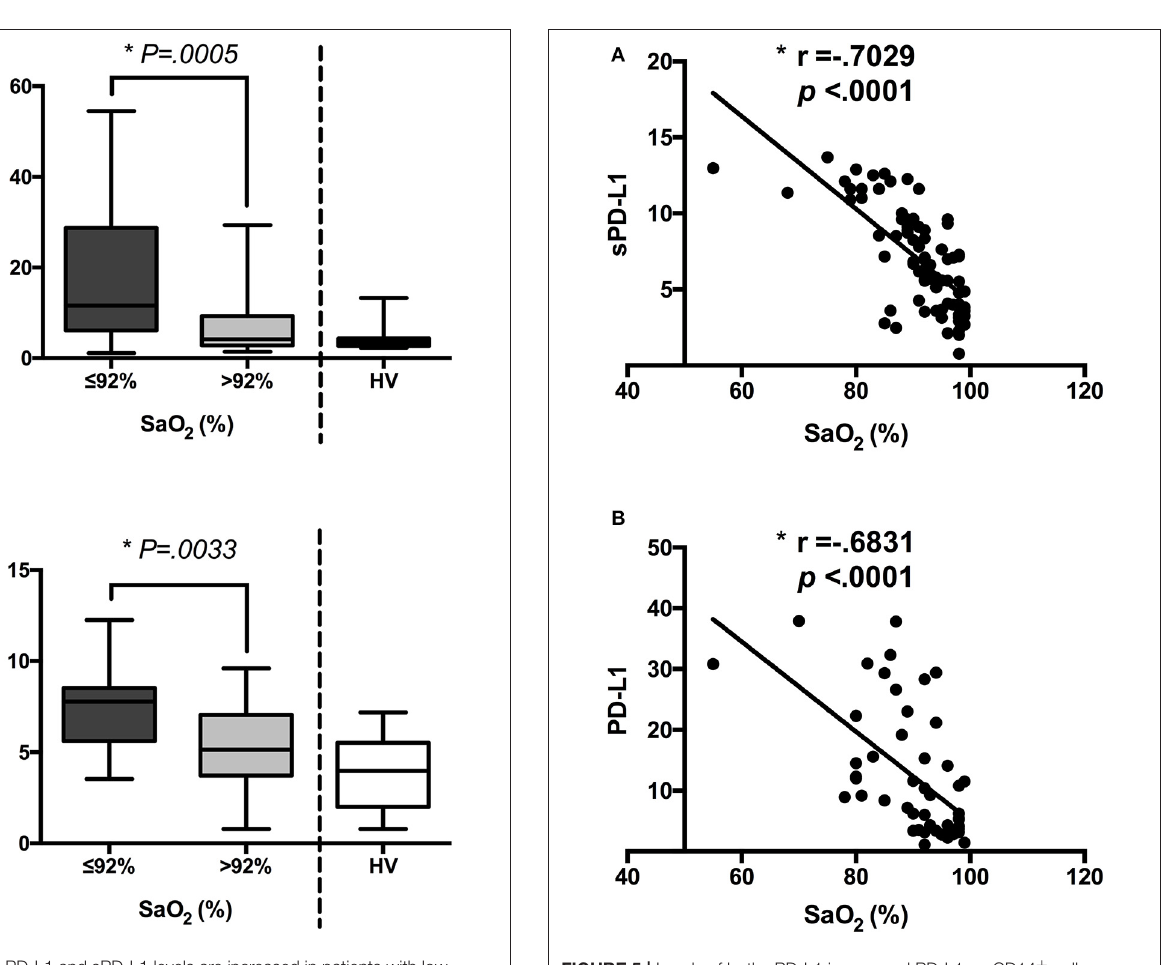
higher in group I than group II, ( χ ² = 5.708, P = 0.017) ( Figure 1B ).